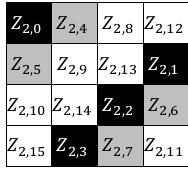
Figure 10: AES state after the second ShiftRows